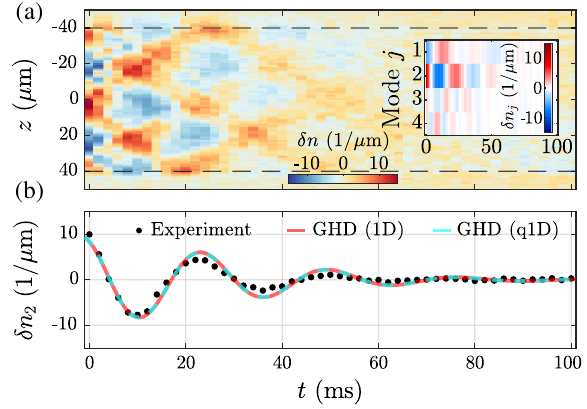
FIG. 3. (a) Measured time evolution of the density perturbation δ n ð z; t Þ ¼ n ð z; t Þ − h n ð z; t Þi for a quench of the j ¼ 2 cosine t mode. The temperature is T ¼ 76 ð 7 Þ nK and the mean atomic density is 65 μ m − 1 . The dashed lines mark the theoretical position of the hard walls. The inset shows the evolution of t Þ . (b) Evolution of the addressed the lowest density modes δ n j ð mode δ n 2 ð t Þ with GHD theory comparison.